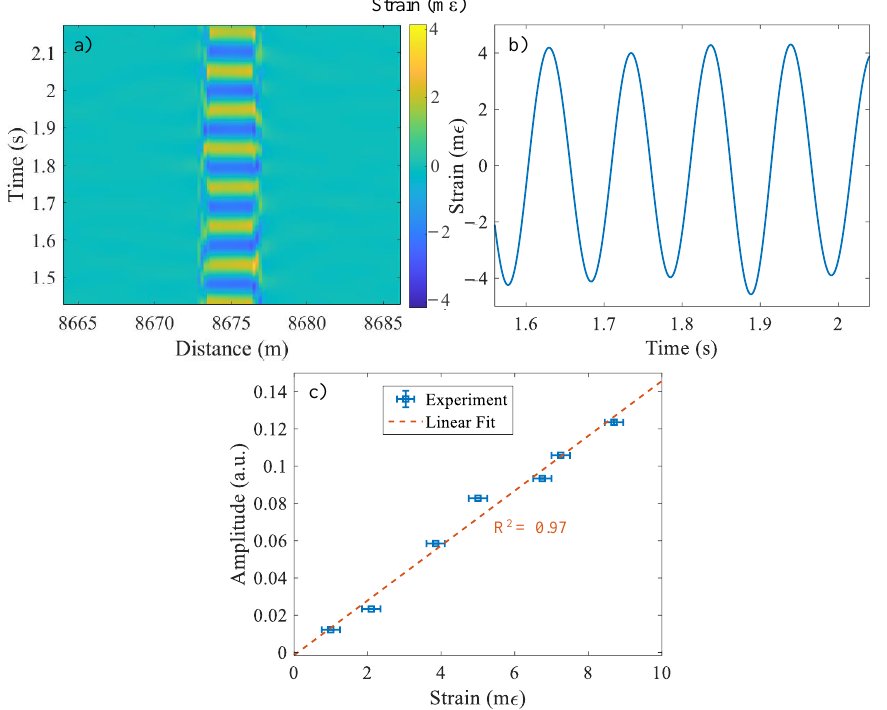
Figure 5. ( a ) Response of the B-DAS system as a function of distance in time for an input sinusoidal strain wave of f ∼ 10 Hz with a peak-to-peak displacement of 17.2 mm over 4 m of SMF, ( b ) 2D plot of the same response at the middle of the 4 m-fiber, and ( c ) amplitude of the sensor output and its linear fit in terms of the applied peak-to-peak strain at f ∼ 10